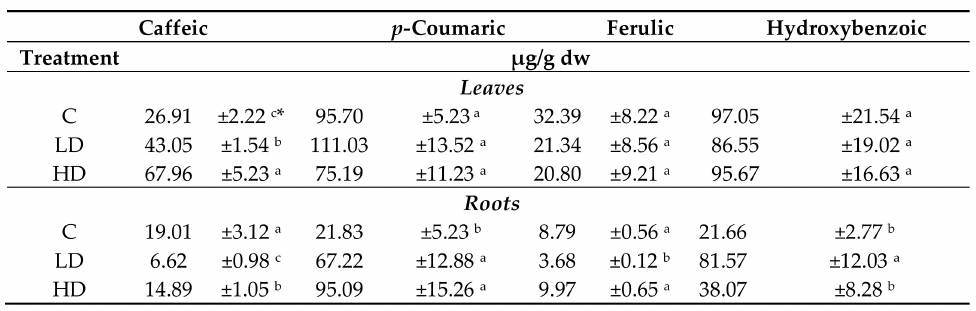
Table 3. Content of the most abundant phenolic compounds detected in leaves and roots of maize plants grown for 15 days in sand in the presence or not of AA309. C = untreated plants; LD = Low AA309 dosage; HD = High AA309